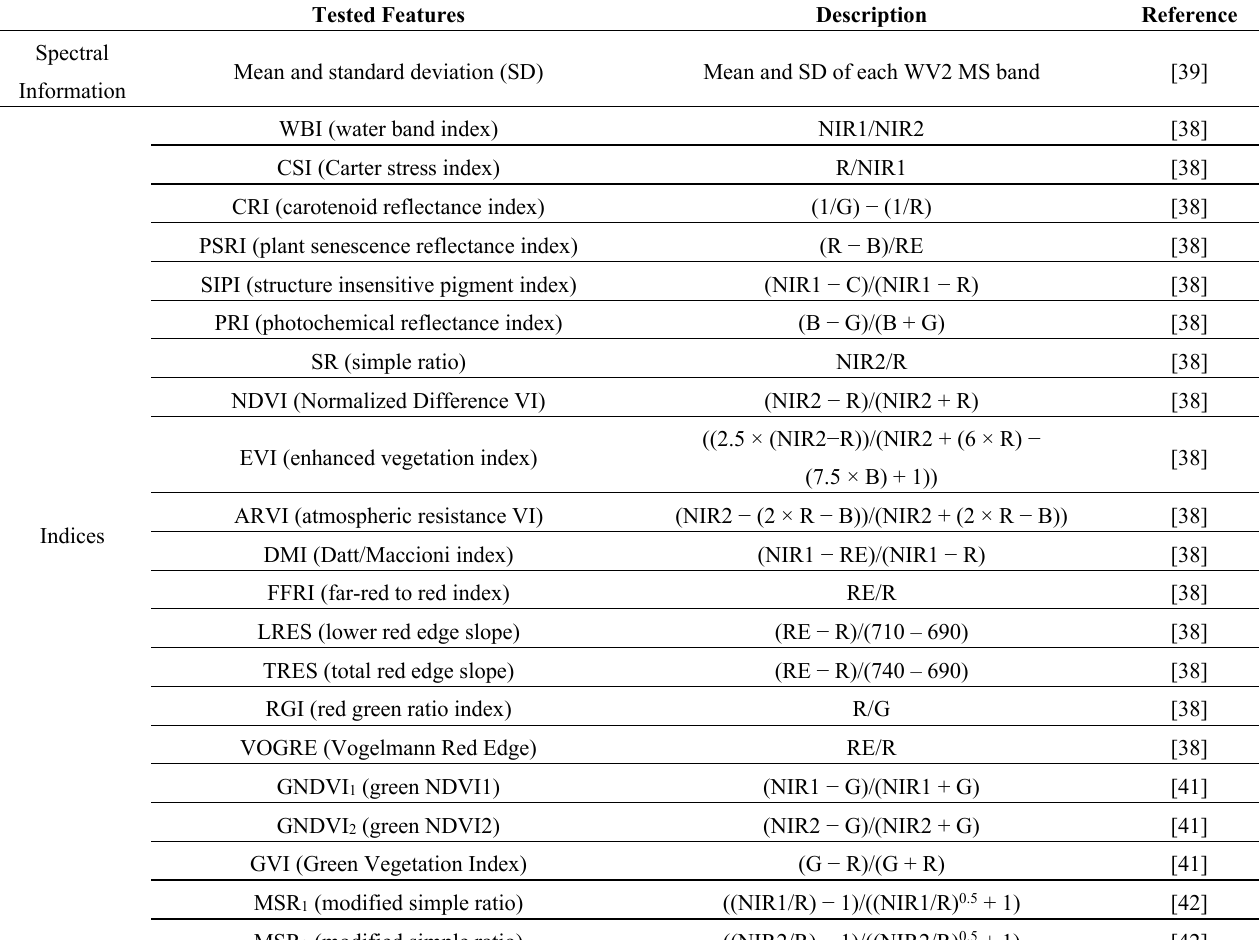
Table 4. WV2 multispectral (MS) single orthoimage object-based